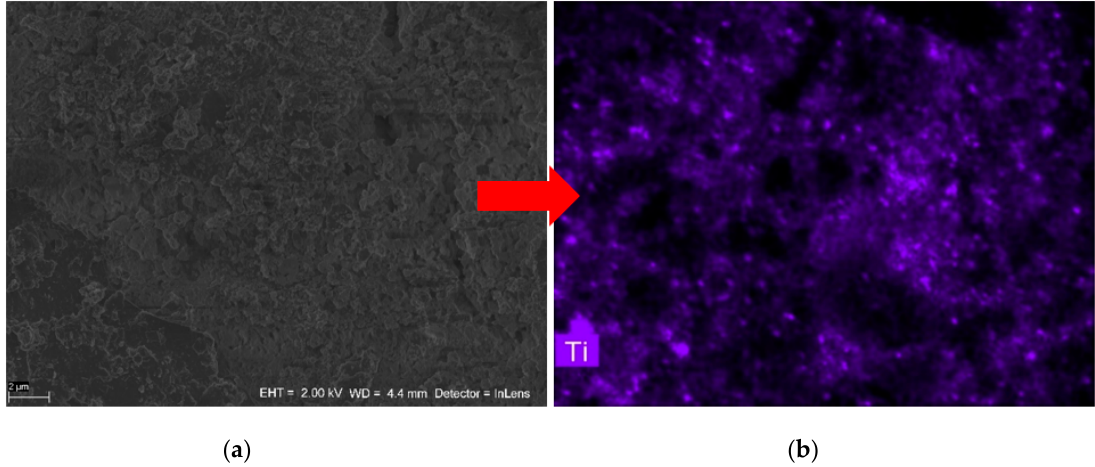
Figure 9. SEM image of the sample surface (InLens detector at ETH = 2.00 kV). ( a ) Morphology, ( b ) EDS maps of titanium in the presented region.